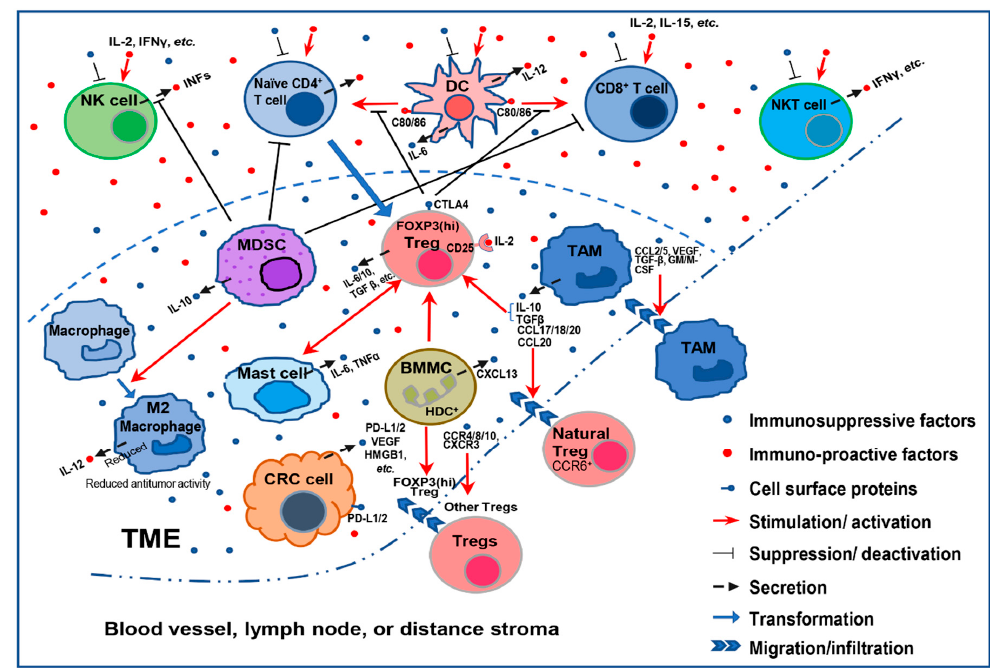
Figure 1. A simplified schematic showing how immunosuppressive cells in the TME assist tumor cells escape from immunosurveillance. In the TME, the immunostimulatory cytokines (IL-2, IFN- γ , IL-15, etc.) may enhance or activate immunity against tumor cells. Nevertheless, immunosuppressive cytokines (PD-L1, TGF β , etc.) secreted by immunosuppressive cells or cancer cells may inhibit proliferation or activation of naïve CD4 + T cells and tumor-killing immune cells, including natural killer (NK) cells, CD8 + T cells, and NKT cells. Meanwhile these immunosuppressive cytokines (CCR4, CCL20, TGF β , etc.) secreted by tumor-associated macrophages (TAMs), mast cells, and bone marrow myeloid cells (BMMCs) may assist tumor infiltration of immunosuppressive cells, such natural T regulatory cells (Tregs) and TAMs, and support proliferation or activation of immunosuppressive cells, such as Tregs. Immunosuppressive cells, including myeloid-derived suppressor cells (MDSCs) and Tregs, may also inhibit the function or activation of NK cells, T cells, and NKT cells independent of cytokines.